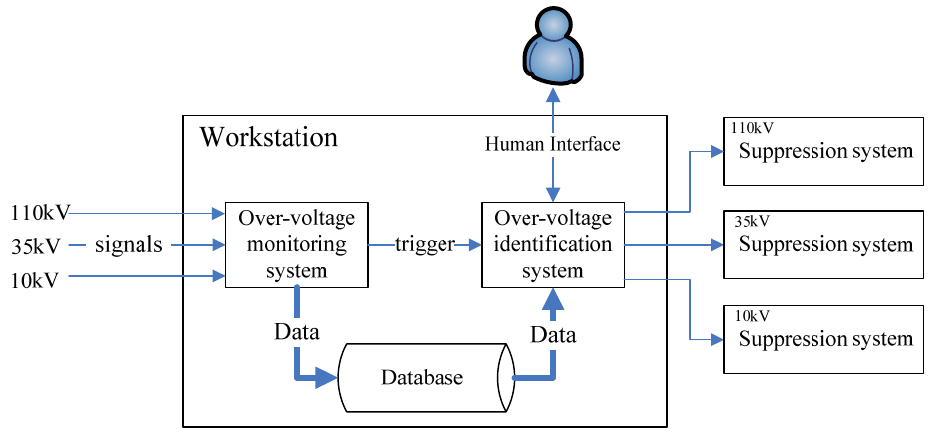
Figure 4. Workflow of over-voltage monitoring-identification-suppression